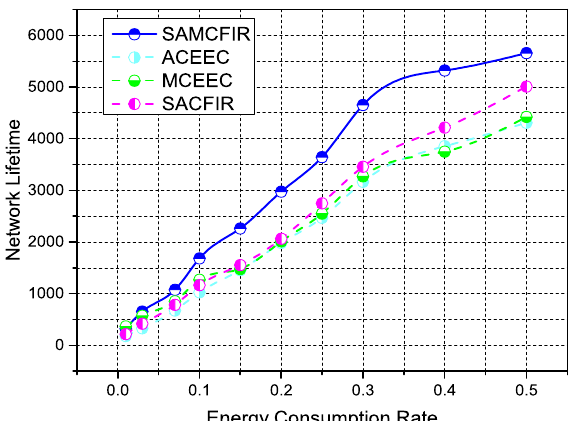
Figure 9. Energy consumption rate as network operation progress in network of 100 m × 100 m with 100 nodes.